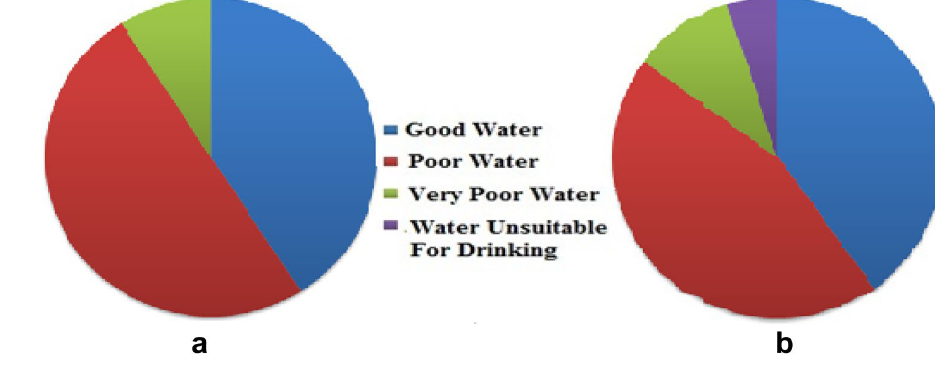
Fig. 13 Categorisation of groundwater according to